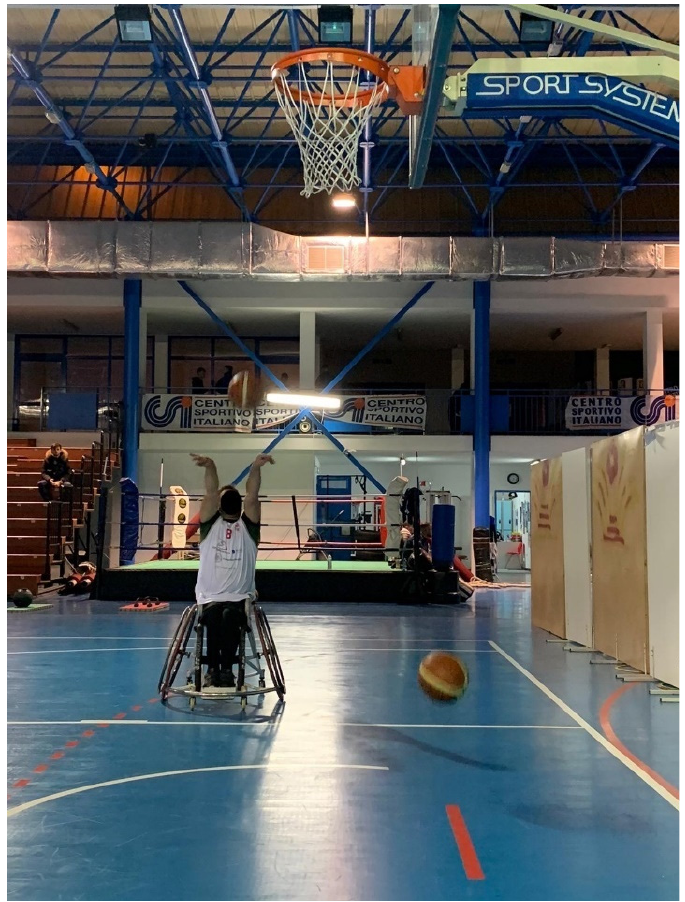
Figure 5. Wheelchair basketball. Picture of the patient in-wheelchair during a training session.